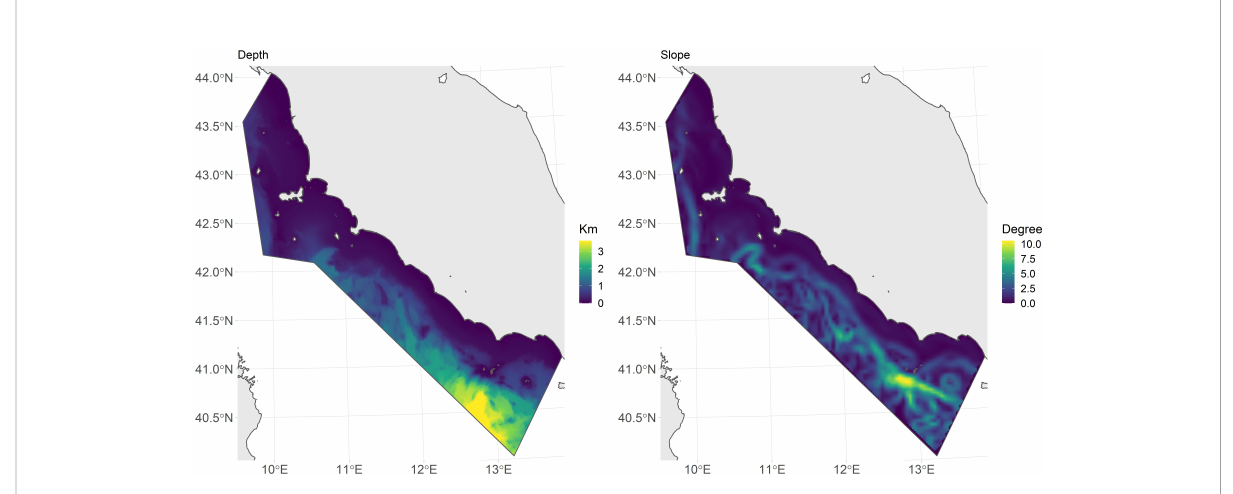
FIGURE 3 Bottom depth (left panel) and slope (right panel) in the study area.